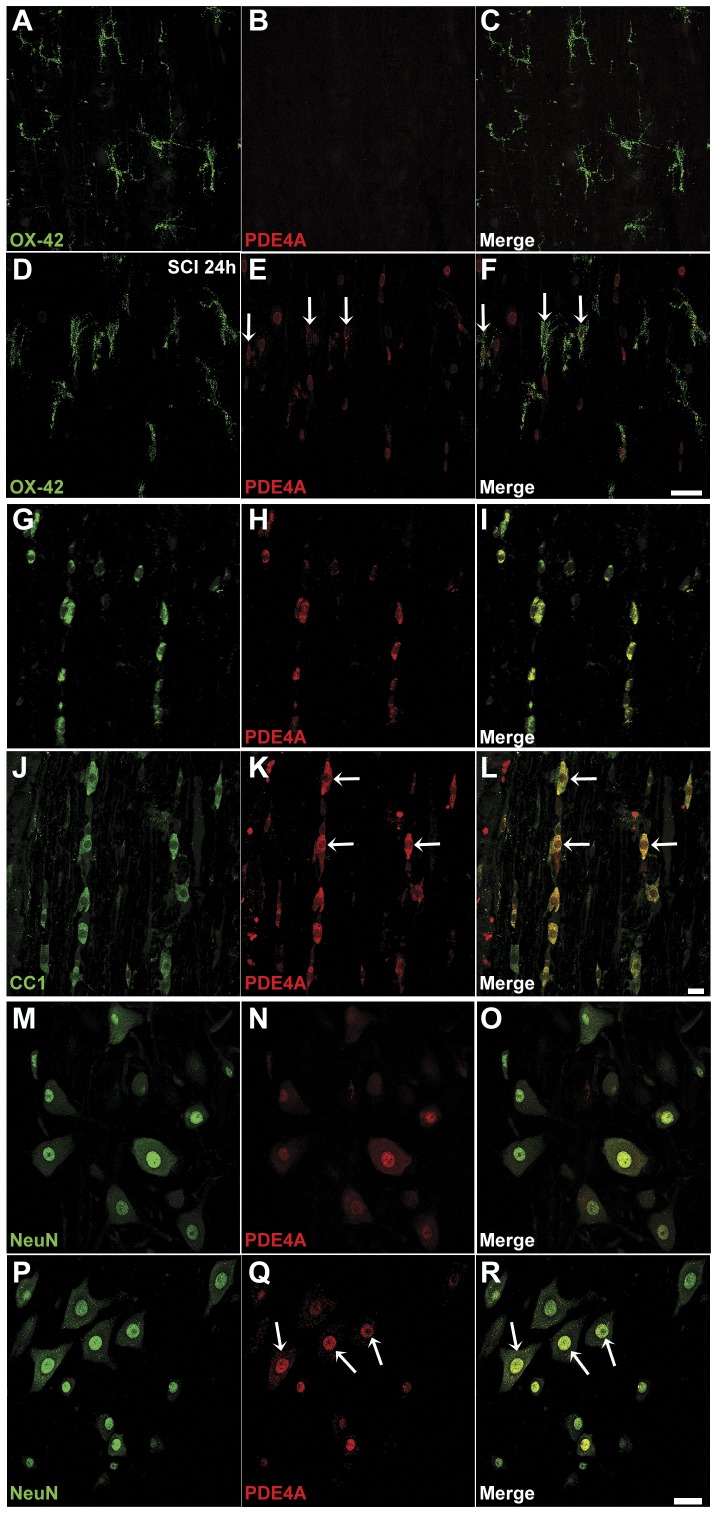
Immunochemical detection of PDE4A protein at 24 h after SCI shows an induction of expression in microglia, but no apparent change in neurons or oligodendrocytes.
A–C. PDE4A (red) is virtually absent from OX-42+ microglia (green) in uninjured spinal cord. D–F. At 24 h post-SCI there is an induction of PDE4A in microglia, with localization to the cytoplasm and processes. G–L. APC-CC1+ oligodendrocytes within uninjured spinal cord show PDE4A expression throughout the cell body (G–I) that appears unchanged at 24 h post-SCI (J–L). M–R. Similarly, basal PDE4A expression in NeuN+ neurons (M–O), which appears cytoplasmic, peri-nuclear and/or nuclear, appears unchanged at 24 h post-SCI (P–R). White arrows indicate cells that have immunochemical co-localization of cell-specific markers and PDE4A. Scale bars = 40 µm.